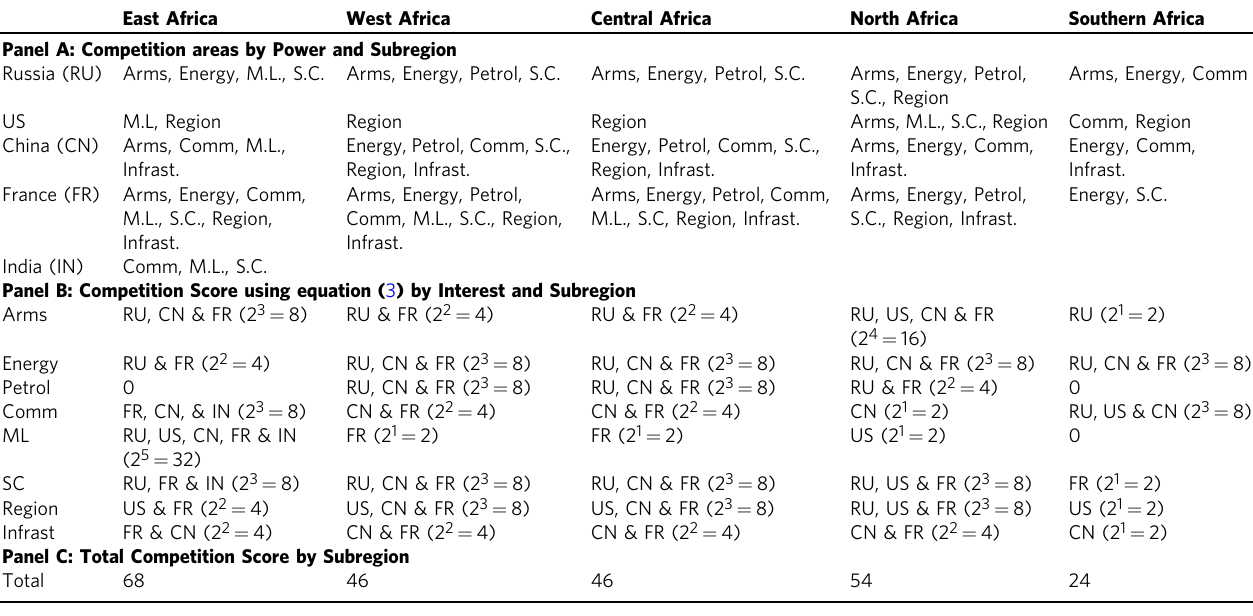
Table 2 Competition information and score by powers, interests, and subregions in Africa.